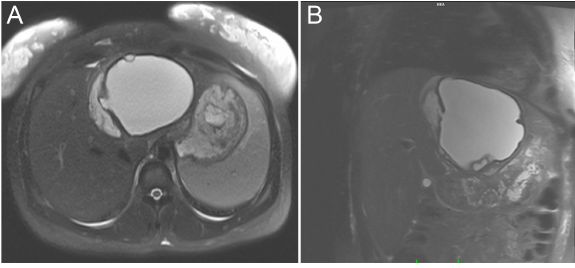
Figure 3. Non-contrast abdominal computed tomography scan shows rupture of the right lobe Figure 4. A,B. Axial (A) and coronal (B) T2-weighted magnetic resonance image shows intrahepatic hydatid cyst of the liver into the perihepatic area. rupture of the left lobe hydatid cyst of the